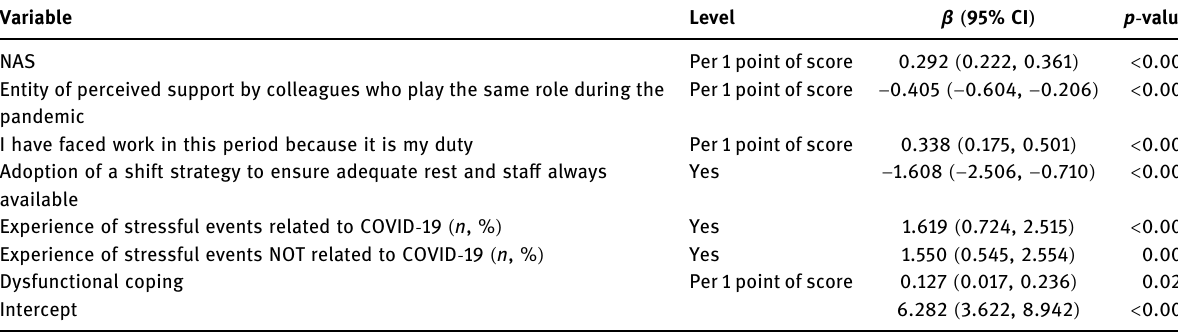
Table 4: Multivariable generalized linear regression model of factors evaluated for an association with the primary outcome ( WE ) Variable Level β ( 95% CI ) p - value NAS Per 1 point of score 0.292 ( 0.222, 0.361 ) < 0.001